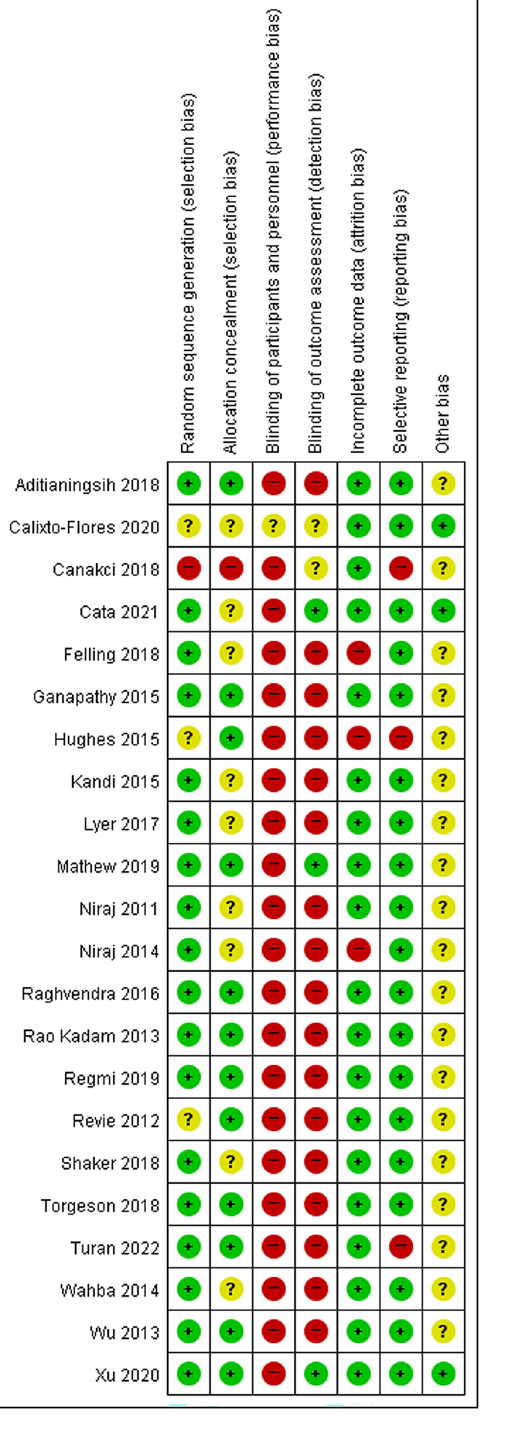
Figure 2. Summary of risk of bias